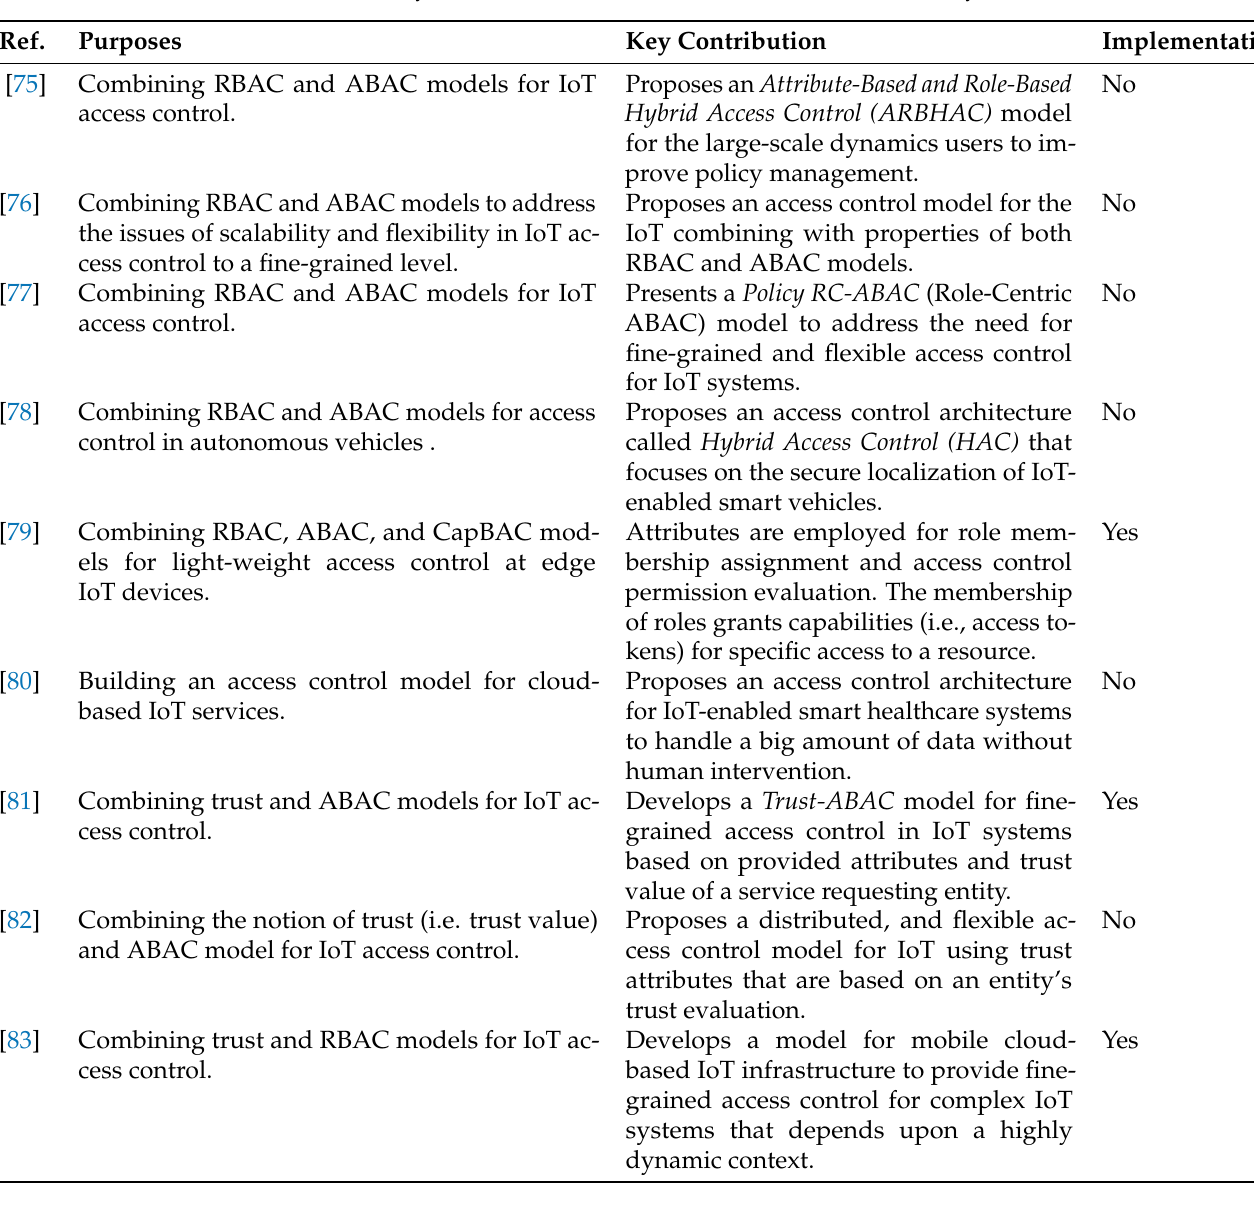
Table 3. Summary of Access Control Mechanisms for the IoT based on